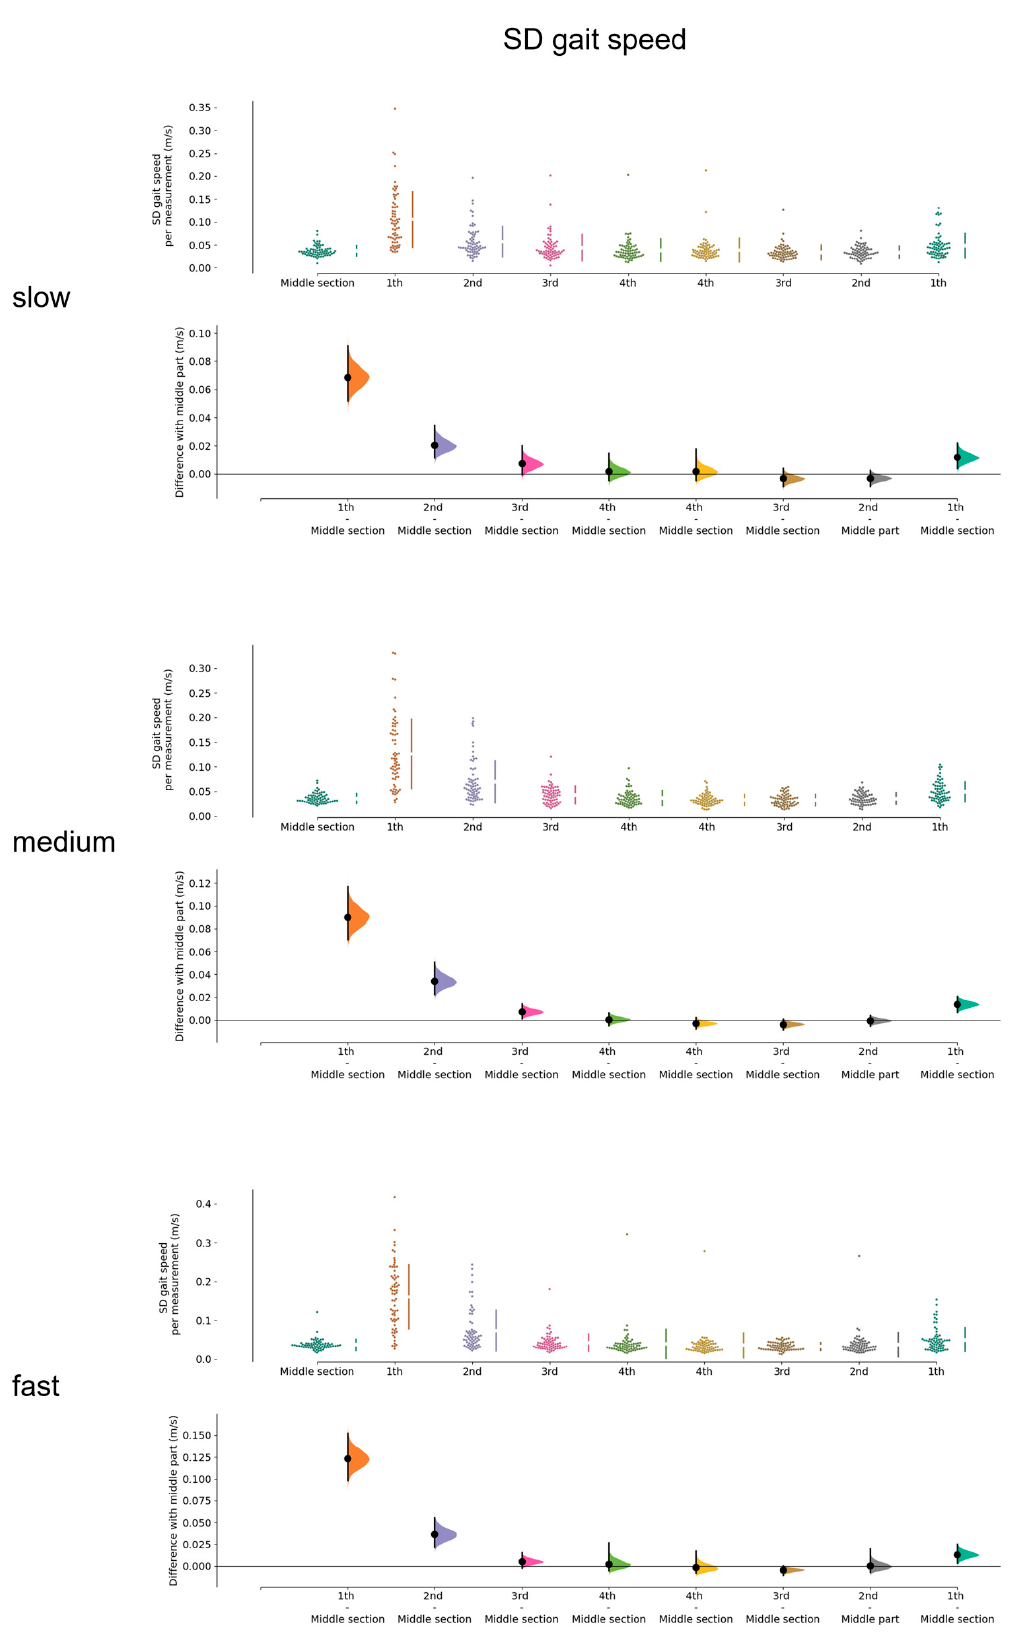
Figure A4. SD of the different participants during the walking trajectory, and the mean differences and associated 99% CI of the first and last 4 strides around a turn. The top subplot includes data of the slow gait speed group, the middle subplot of the medium gait speed group and the bottom subplot of the fast gait speed group.